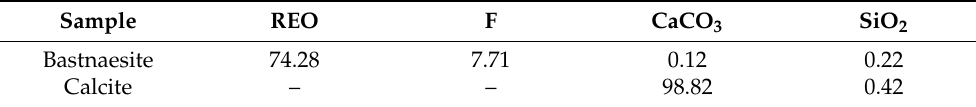
Table 1. Elemental analysis results (%) of bastnaesite and calcite sample.